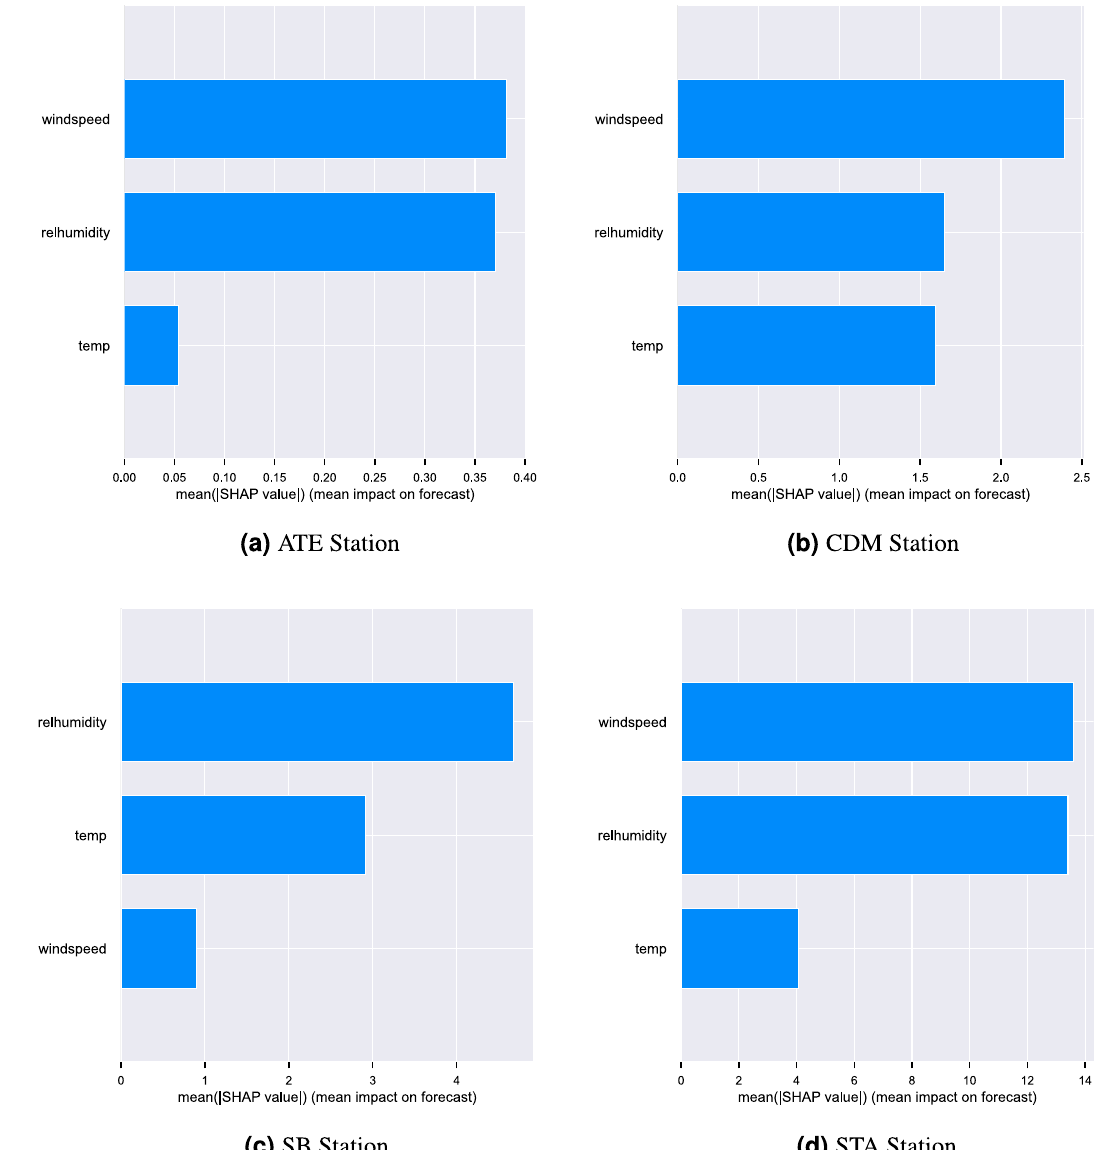
Figure 3. Mean impact of selected variables on ozone. Each variable is observed ordered according to the impact with respect to ozone. In the same way, it is observed that both wind speed and relative humidity have the greatest impact on the